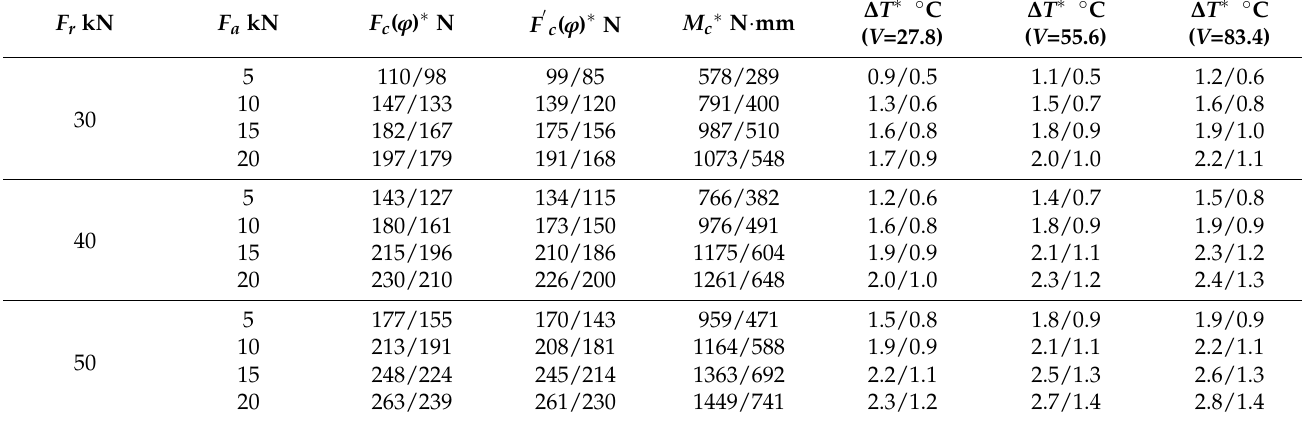
Table 1. The temperature gradient in the rolling bearings, caused by structural changes in the cage and corresponding to various operating